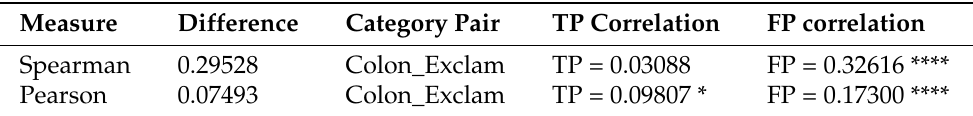
Table 24. Colons and Exclamation marks in High.